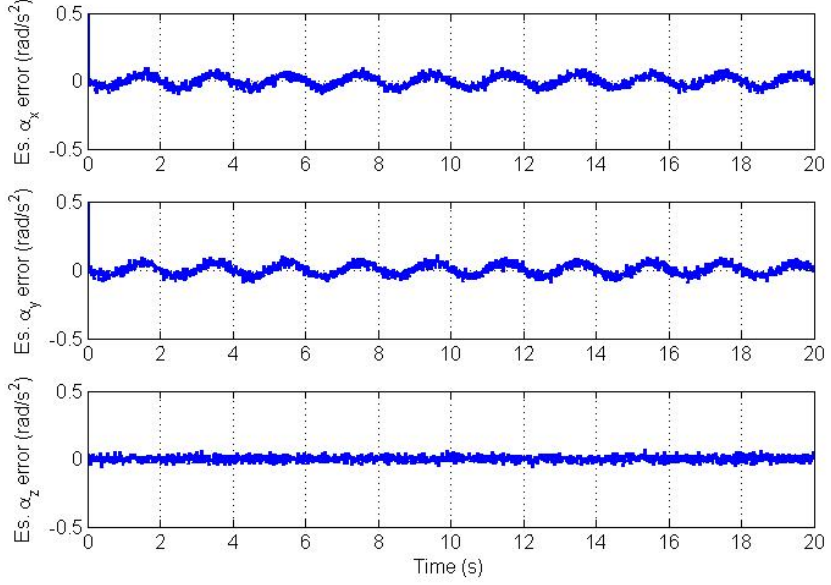
Figure 10. Angular acceleration vector estimation errors for the reduced